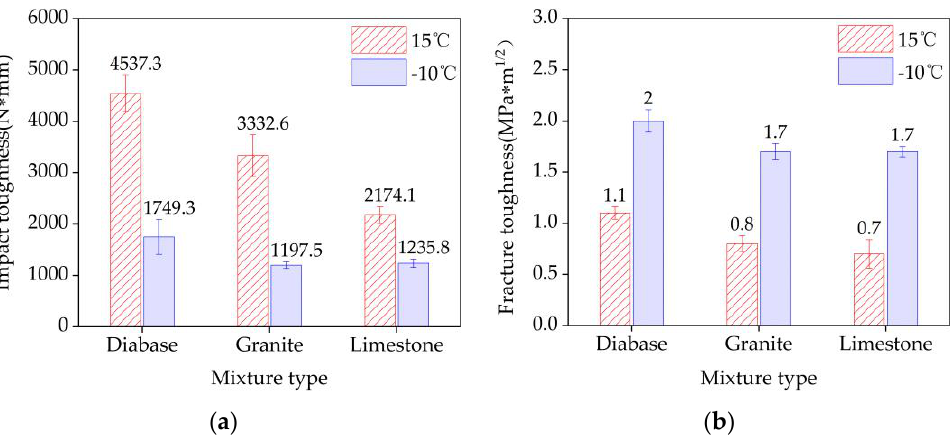
Figure 12. Three-point bending test results of the three mixture beam types: ( a ) impact toughness and ( b ) fracture toughness.